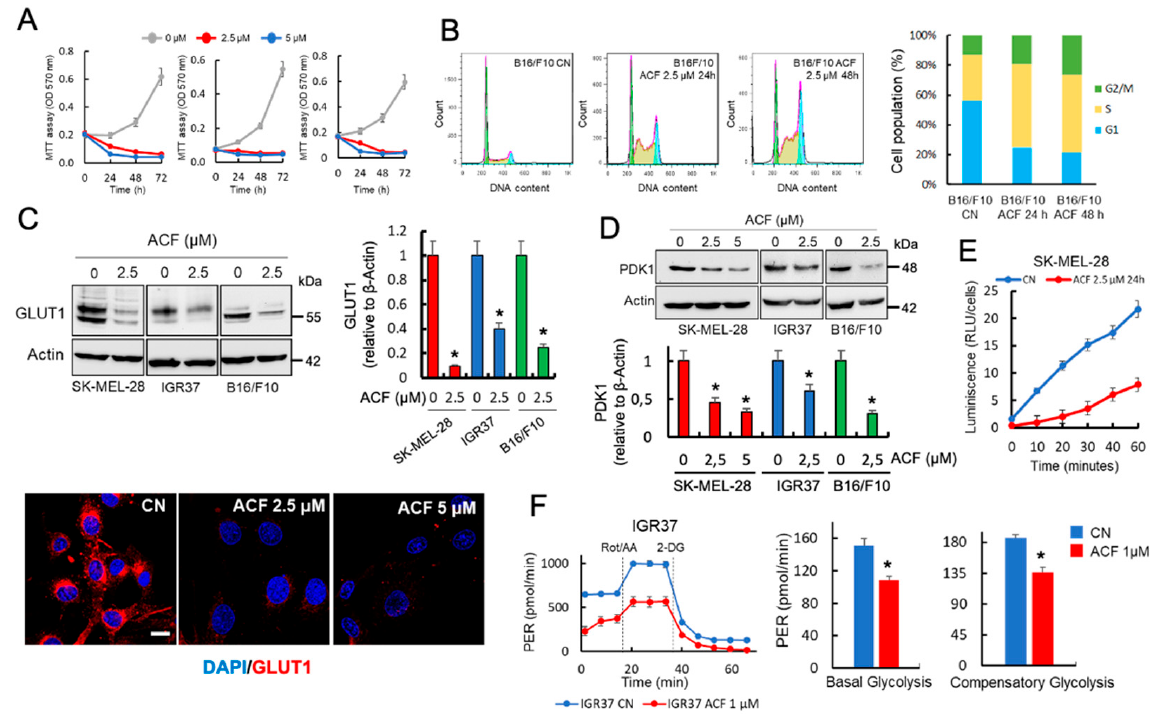
Figure 1. Acriflavine (ACF) restricts glucose availability and suppresses the Warburg effect in mel- anoma cells. ( A ) Effects of ACF on the growth of indicated melanoma cells. Viability was